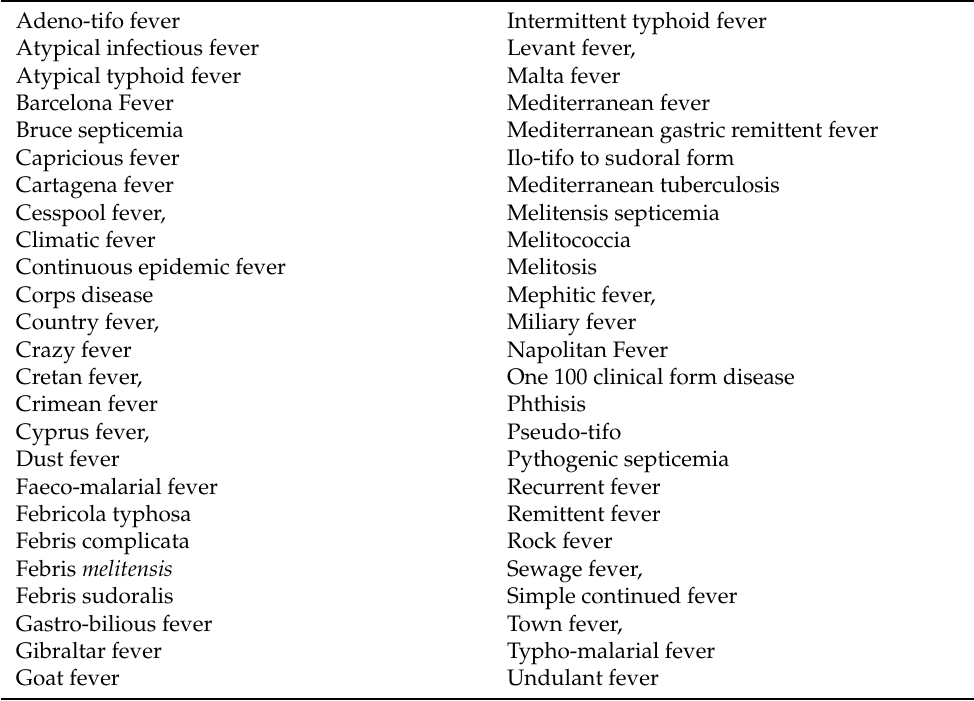
Table 1. The fifty names of brucellosis